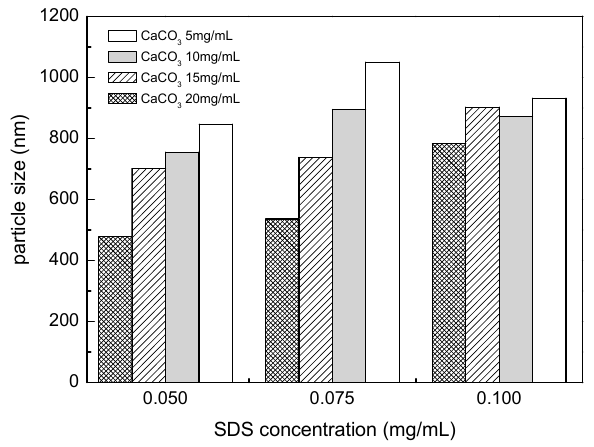
Figure 1. Influence of sodium n -dodecyl sulfate (SDS) and CaCO 3 concentrations on the particle size of templates.